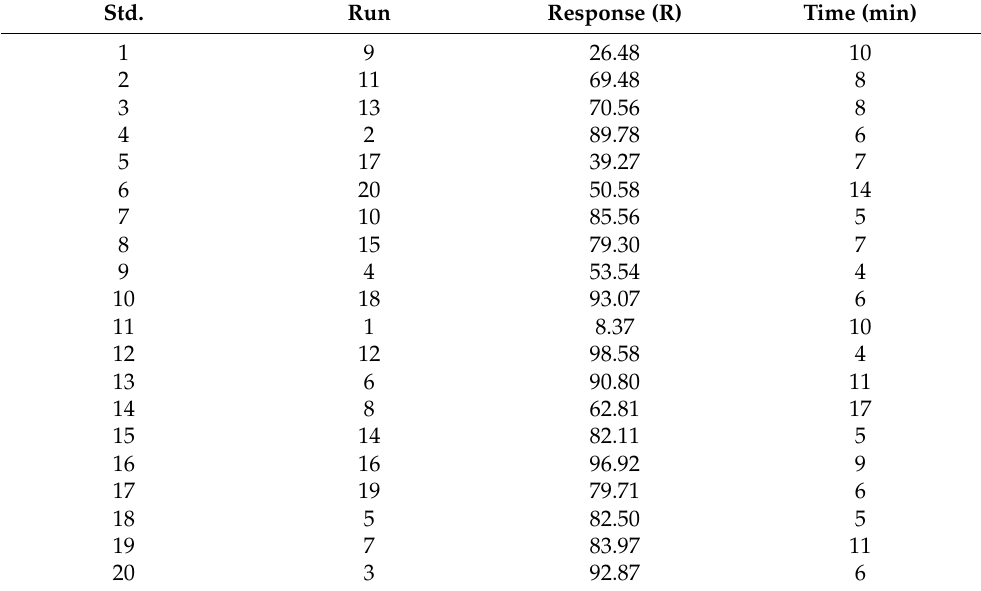
Figure 6. The TGA curve of ZIF-67 (bottom), Pt@ZIF-67 (top). Table 3. Results from experiments designed by RSM.